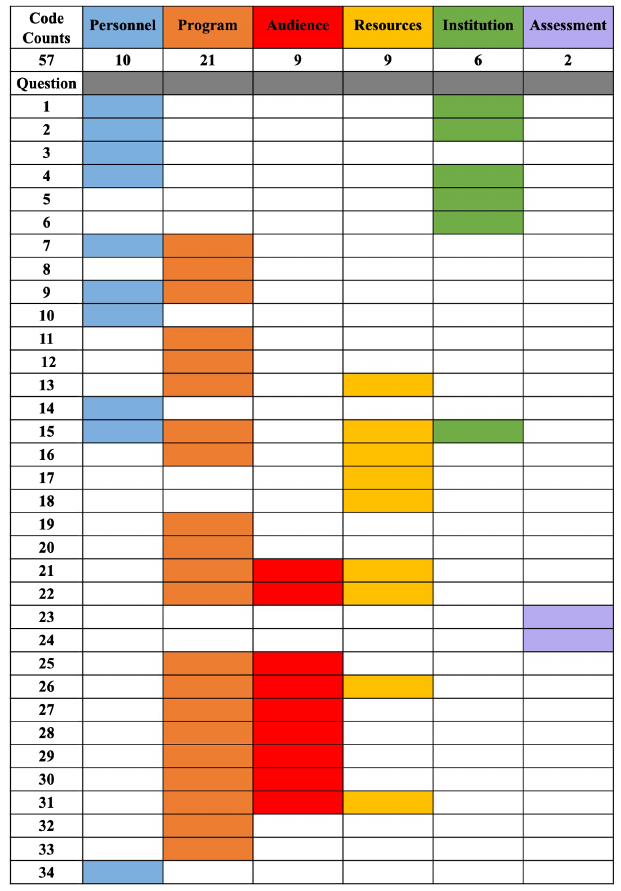
FIG. 2. Organizational theory codes for the survey questions. The six framework themes are color coded for better visualiza- tion. The second row on the table shows the total code counts for the six framework themes. The survey question numbers starting from the fourth row, correspond to the question numbers in the same order they appear in the Qualtrics platform. The 9 optional demographic questions of the survey are excluded from this